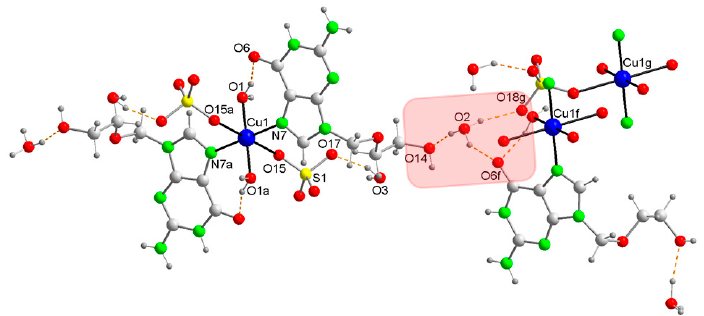
Figure 2. Structure and H-bonding interactions (dashed lines) in 1 . The H 3 O + ion is H-bonded to O-acceptors of three neighboring complex anions. Symmetry codes: a = – x , – y + 1, – z ; f = x + 1, – y + 1/2, z + 1/2; g = – x + 1, y –1/2, – z + 3/2.